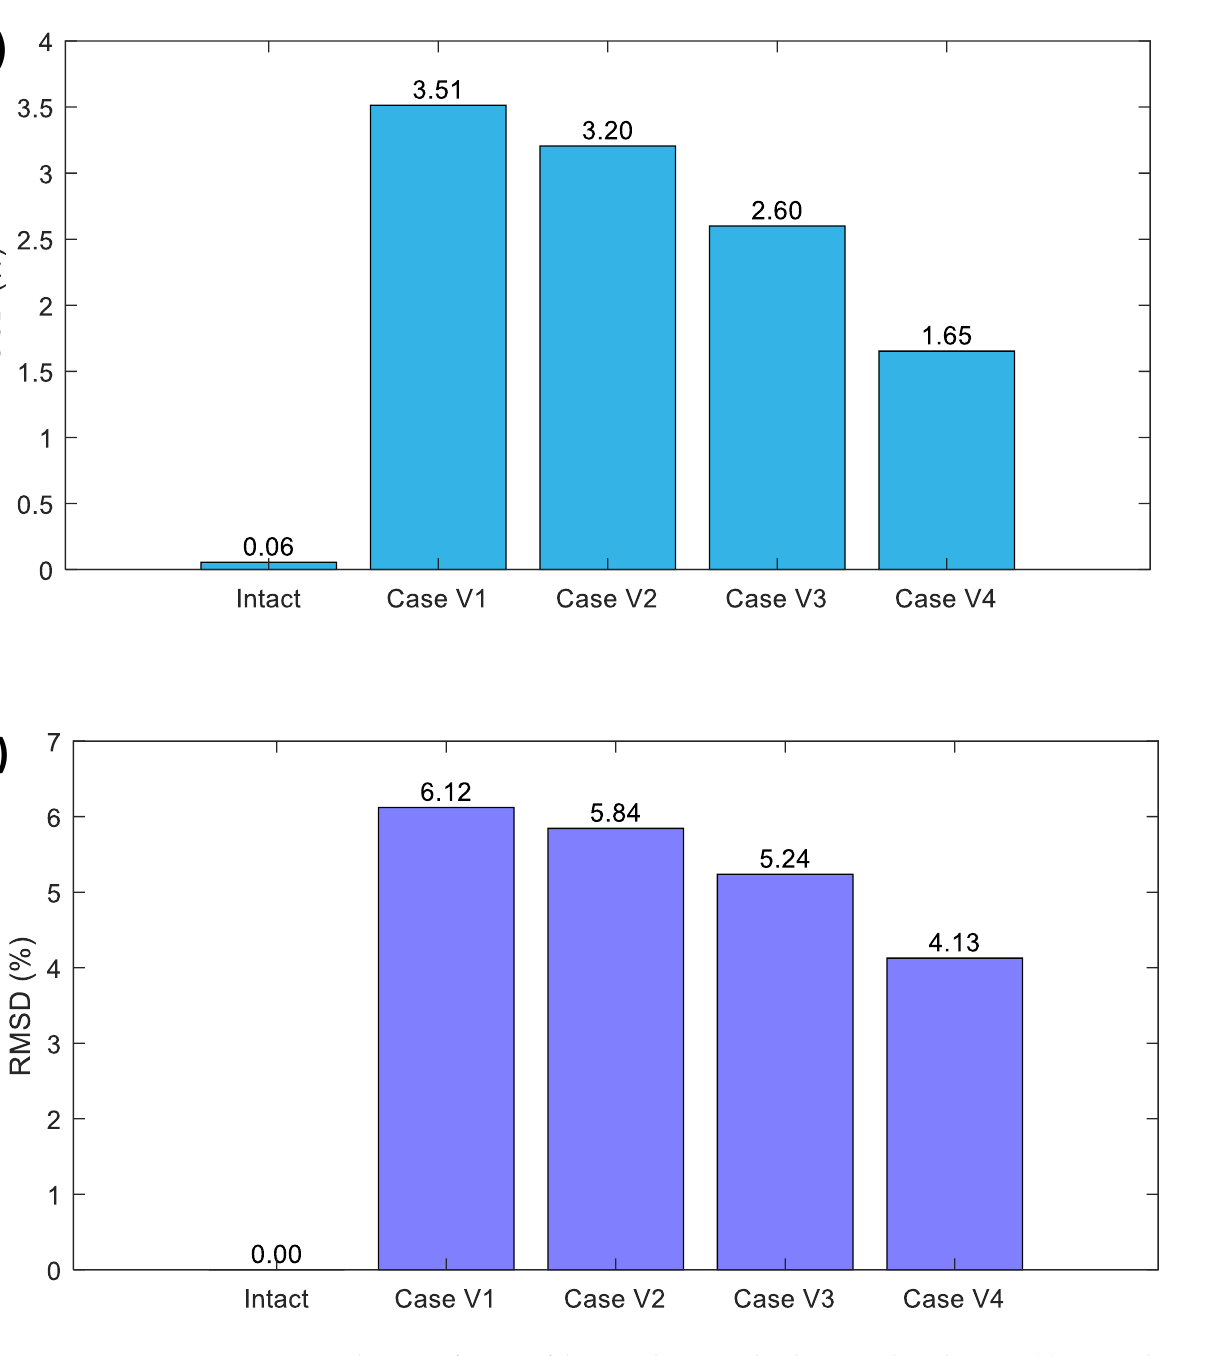
Figure 10. The quantification of the EMI change under the vertical cracks using ( a ) CCD index and ( b ) RMSD index. Linear approximation functions were used to analyze the relationships between the location of the crack and the RMSD and CCD damage metrics. The result for the cases of horizontal cracks is depicted in Figure 11. Both RSMD and CCD datasets fit well with the linear lines, and the R-squared value accounted for 0.95 and 0.94 for the RSMD and CCD datasets, respectively. The metrics decreased as the distance from the transducer to the crack increased. Figure 12 shows the result for the cases of vertical cracks. The R-squared value was 0.93 for the RMSD metric and 0.95 for the CCD metric. It can be seen that both damage metrics showed a linear decrease with the sensing distance. This implies